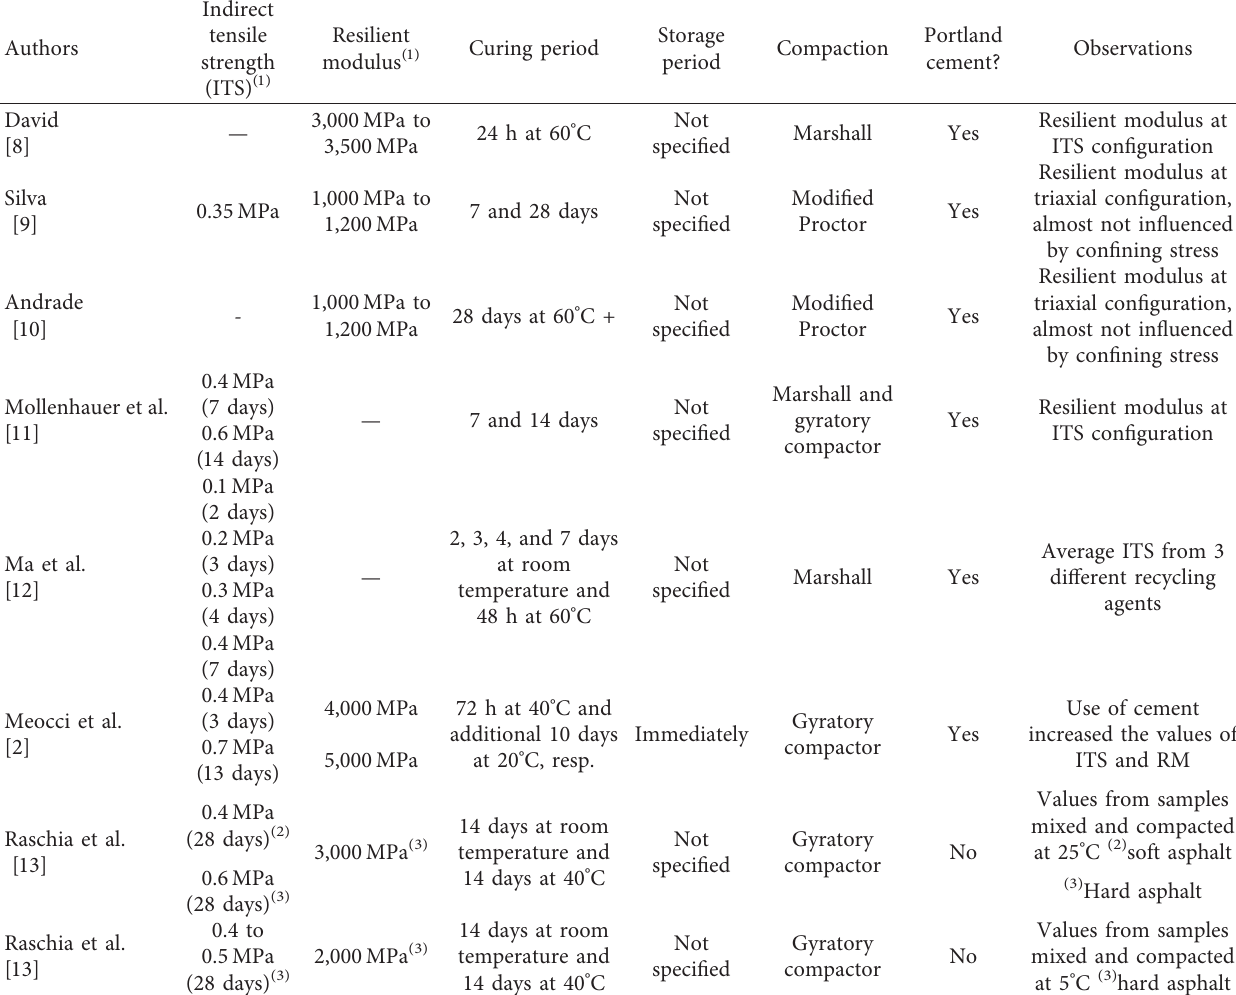
Table 1: Mechanical properties of cold recycled asphalt mixtures with emulsified asphalt-recycling agent.